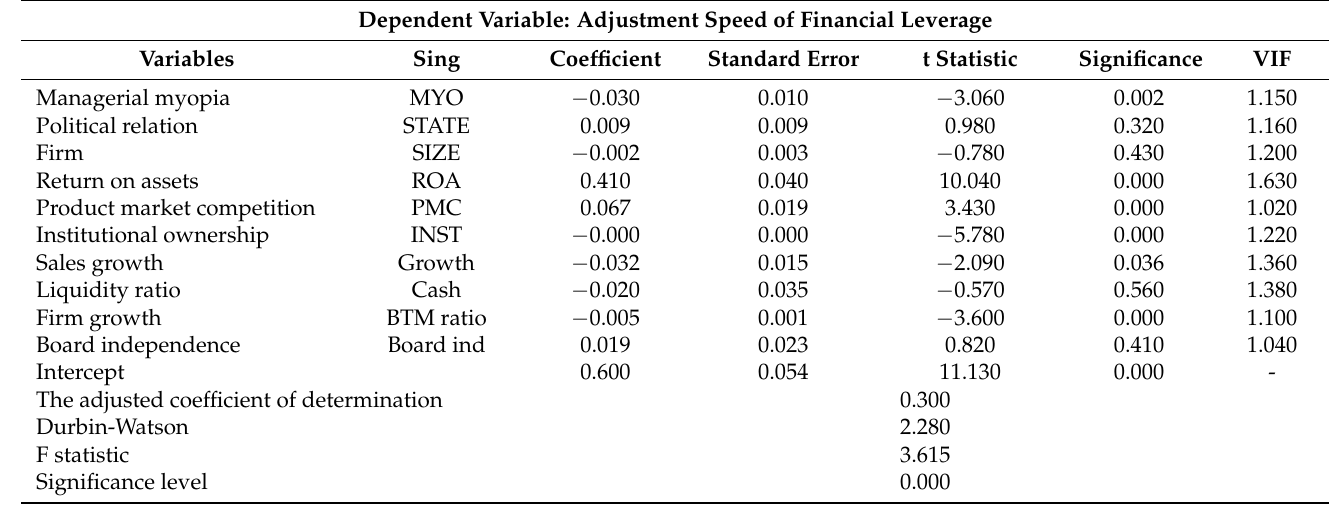
Table 6. The result of the research hypothesis